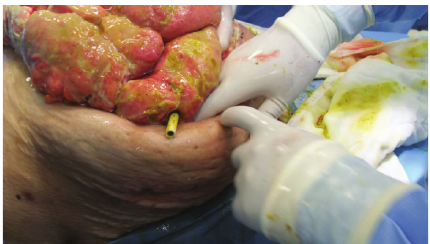
Figure 1: Pezzer drain is seen in EAF.